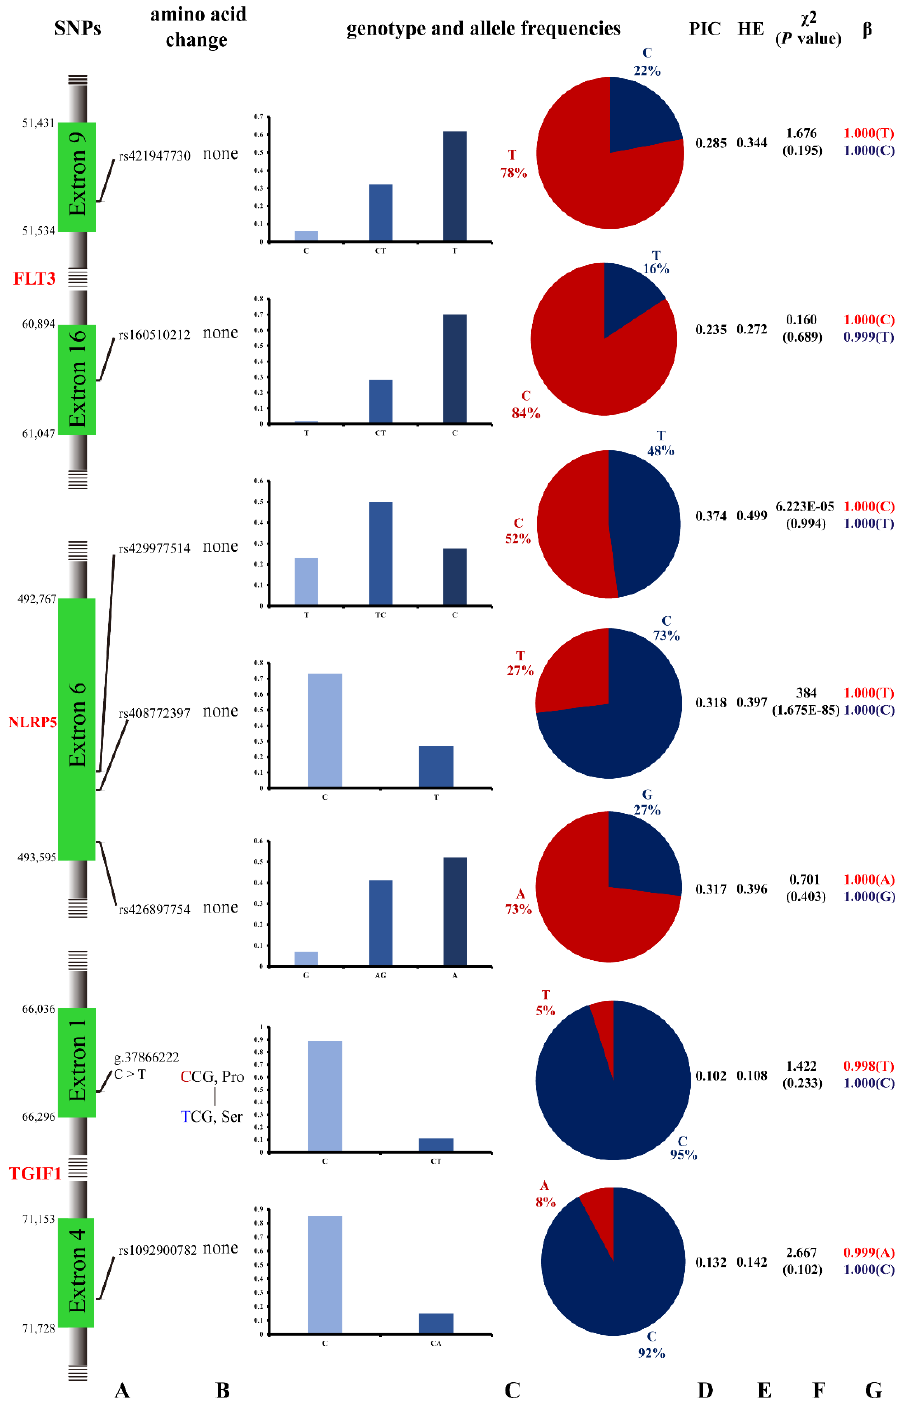
Figure 1. Polymorphisms of the seven SNPs from the FLT3 , NLRP5 , and TGIF1 genes in Small-tailed Han sheep: (a) the position of seven SNPs on the chromosome; (b) the change in amino acids; (c) the genotype and allele frequencies of the FLT3 , NLRP5 , and TGIF1 genes; (d) the polymorphism information content (PIC) test; (e) the heterozygosity (HE) test; and (f) the Hardy–Weinberg equilibrium (HWE) test, χ 2 = (cid:80) ( O − E ) 2 /E , where O and E are observed frequency and expected frequency, respectively. (g) β represents the reliability of the estimated allele